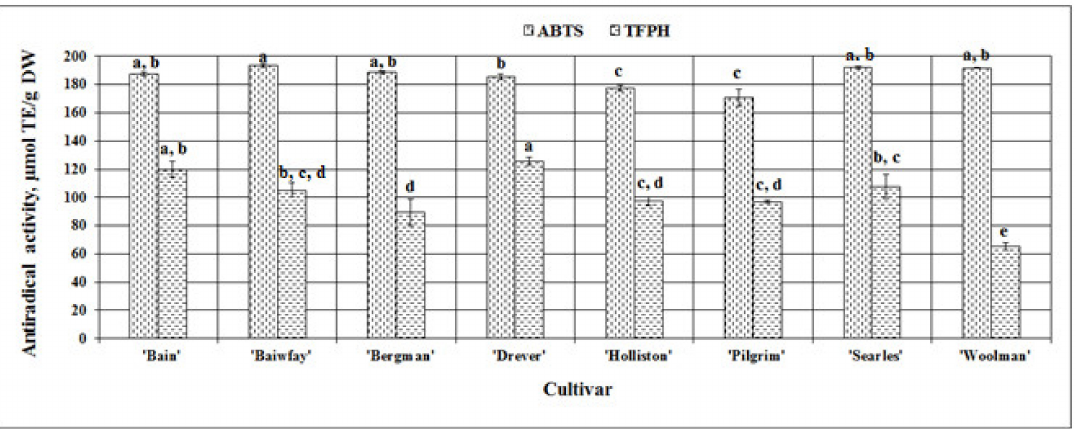
Figure 6. Variability in the antiradical activity in vitro in fruit sample extracts of di ff erent American cranberry cultivars; di ff erent letters indicate statistically significant ( p < 0.05) di ff erences between the studied cranberry fruit samples.